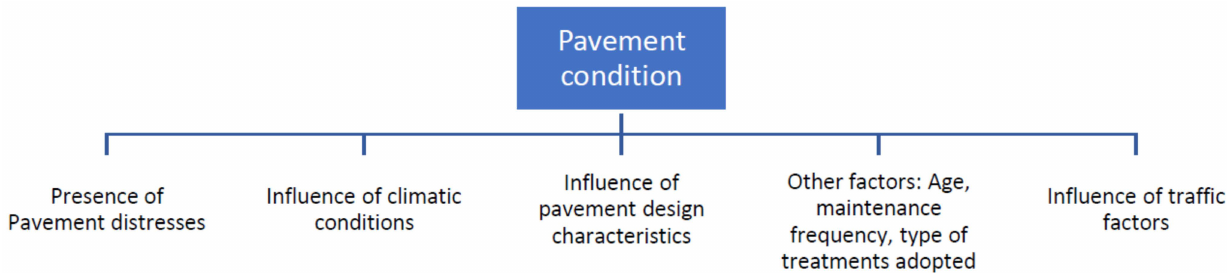
Figure 1. Major factors influencing pavement